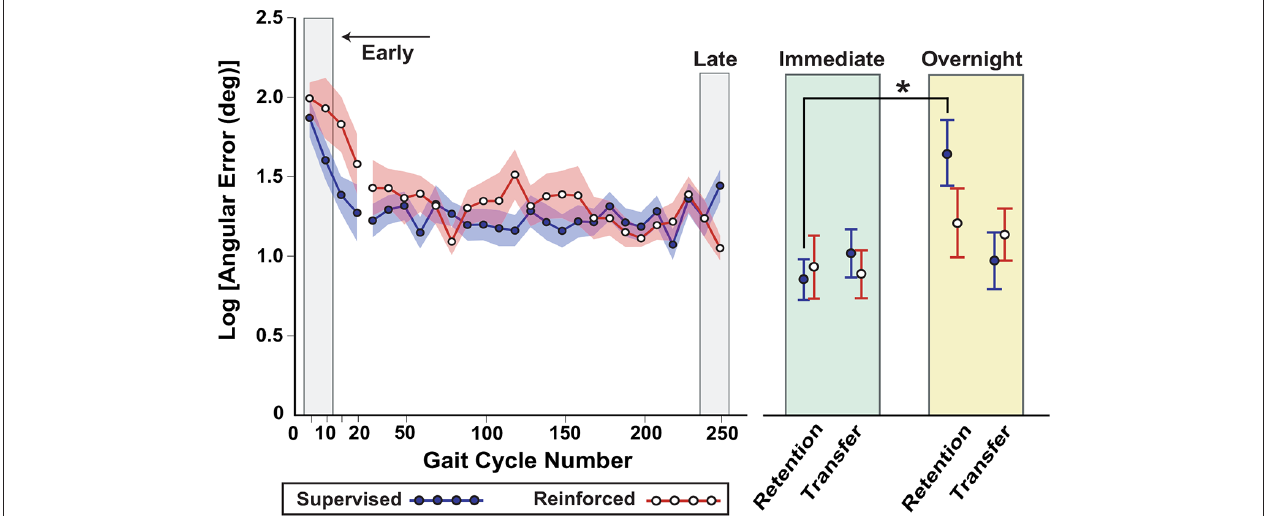
the task were made (the target was reduced from 10 ◦ to 5 ◦ ). At the start of practice the averages are shown for 5-trial bins, while the rest of practice (through late practice) shows 10-trial bins. Shading and error bars indicate the standard error. *Supervised group had a greater increase in error from immediate to overnight retention compared to the reinforcement group (Bonferroni-adjusted p =